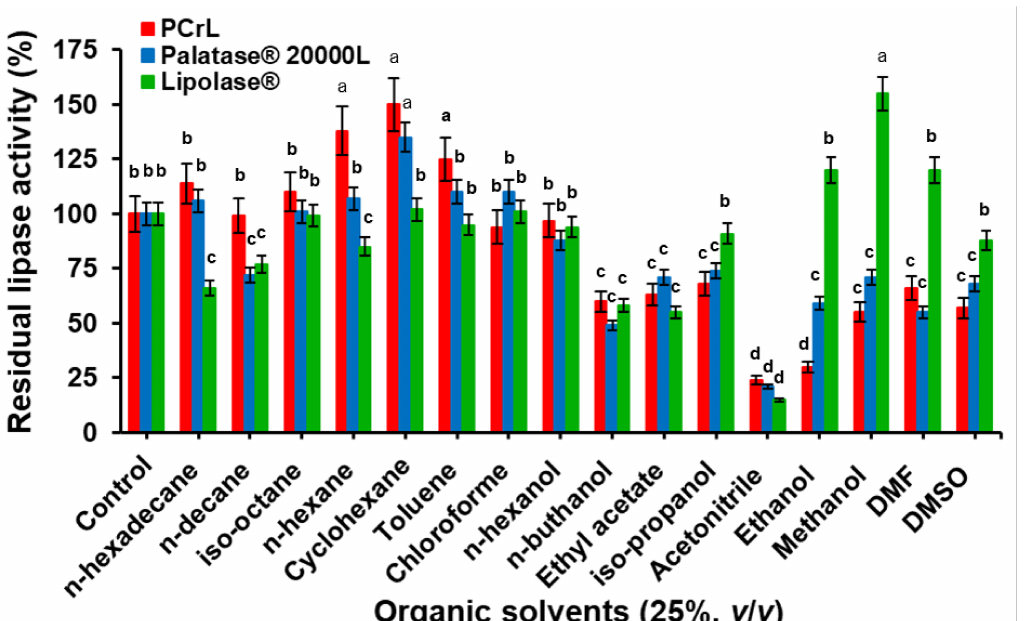
greater than 60% (Figure 8).